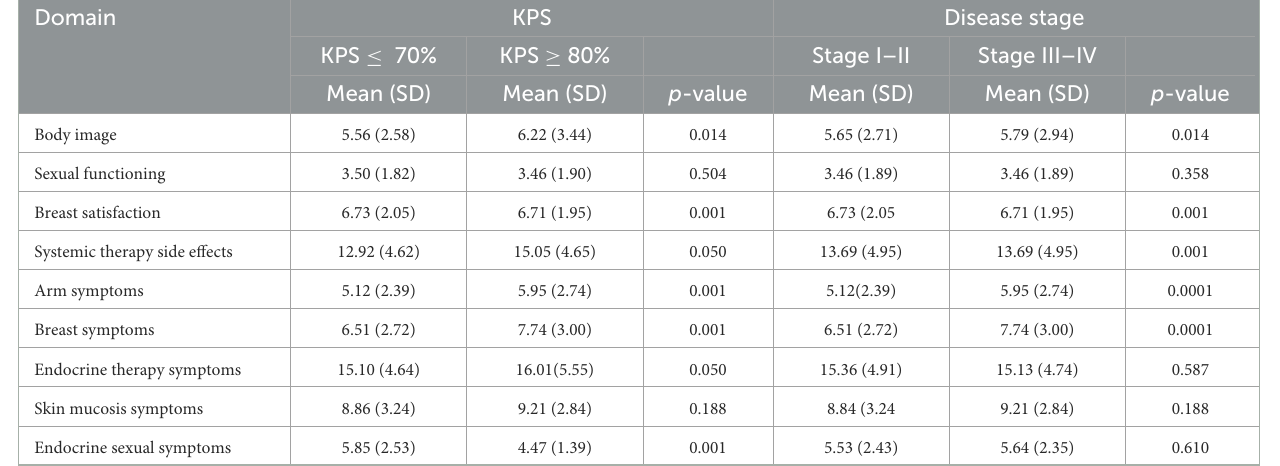
TABLE 3 Known-group differences by Karnofsky performance status and disease